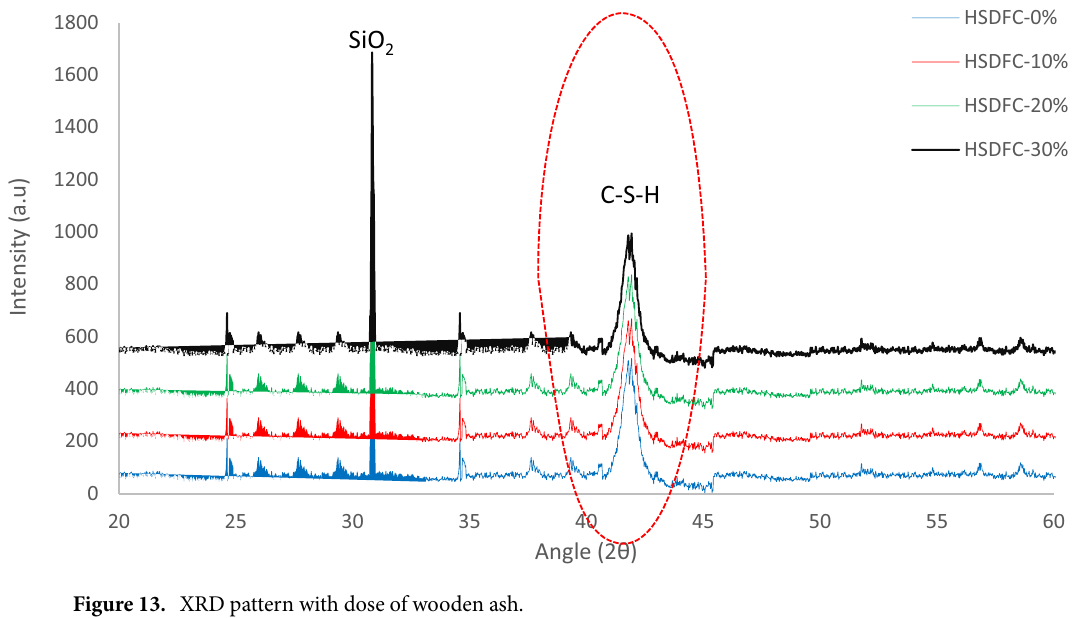
Figure 13. XRD pattern with dose of wooden